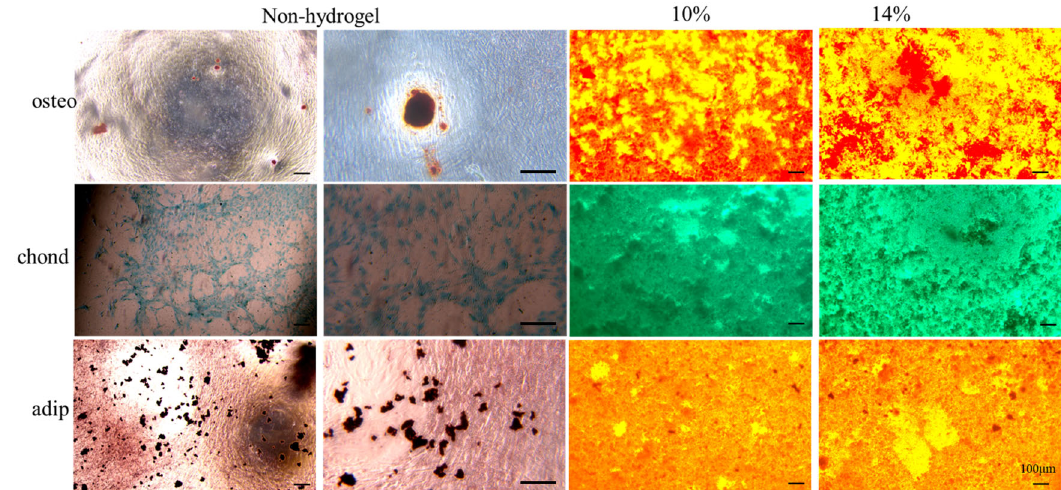
Fig. 4 Differentiation of hUMSCs on hydrogels. Staining images of hUMSCs culture on hydrogels or tissue culture plate in inducing media (osteoblastic, chondroblast and adipose differentiation) for 21